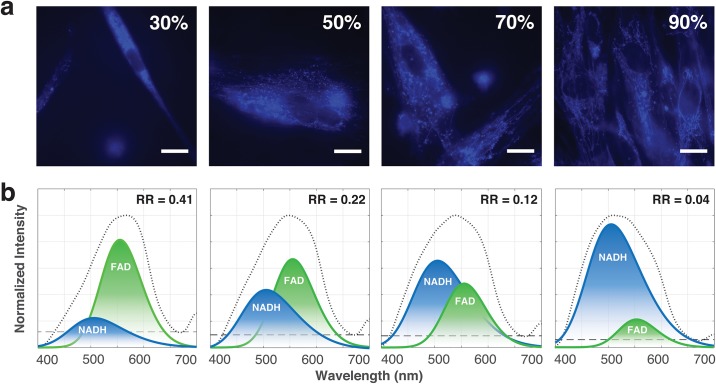
Changes in cellular autofluorescence at different confluencies.Representative cellular autofluorescence (a) images and (b) corresponding decomposed spectra at confluencies of 30%, 50%, 70% and 90%. In (b), black-dotted line represents the measured spectra. The blue and green curves indicate the constituent emissions by NADH and FAD respectively; while the black-dashed line is a constant component used in the fitting. Corresponding redox ratios (RR) are indicated for each decomposed autofluorescence spectrum. Scale: White bars represent 20μm.